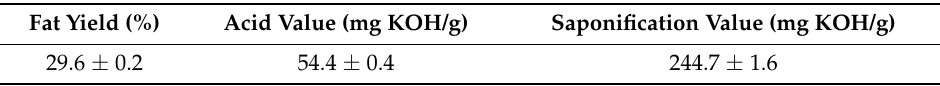
Table 1. Properties of crude soursop seed oil.